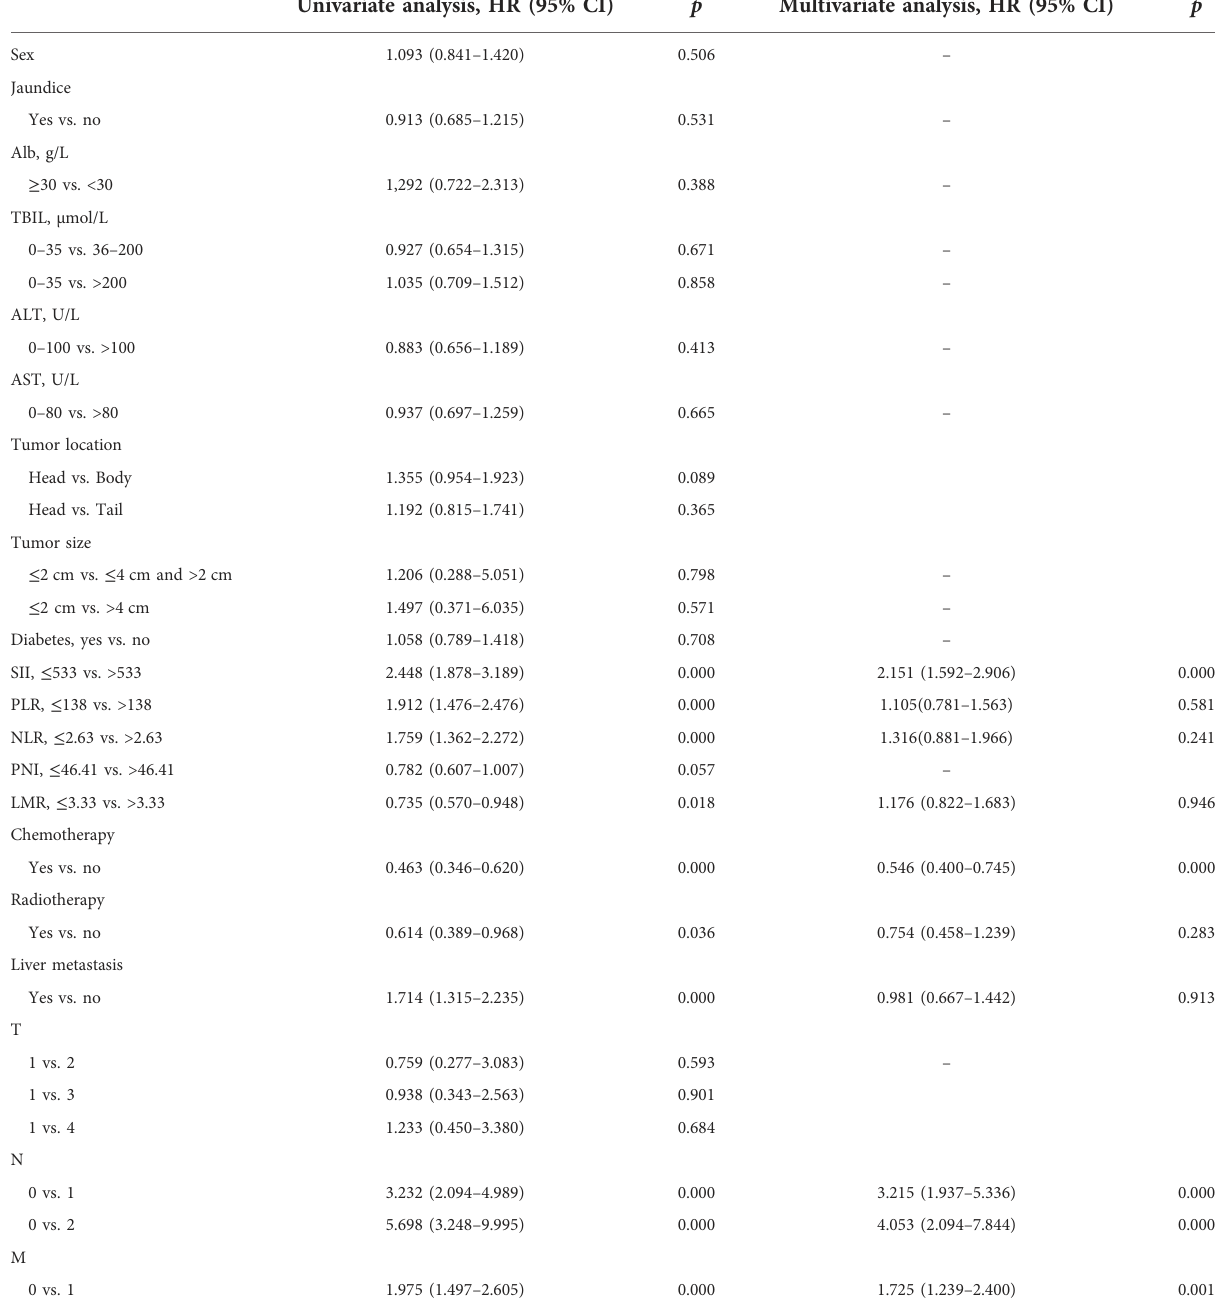
TABLE 2 Univariate and multivariate cox proportional-hazard regression analysis of